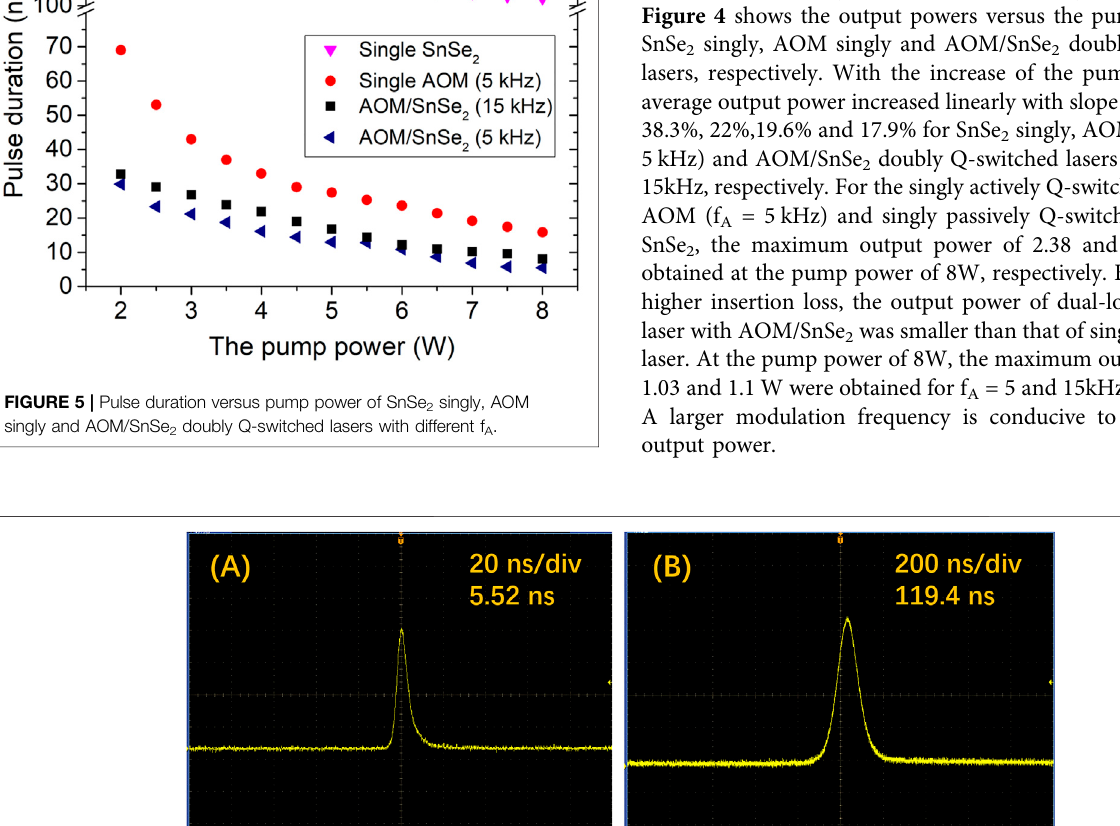
Frontiers in Physics |